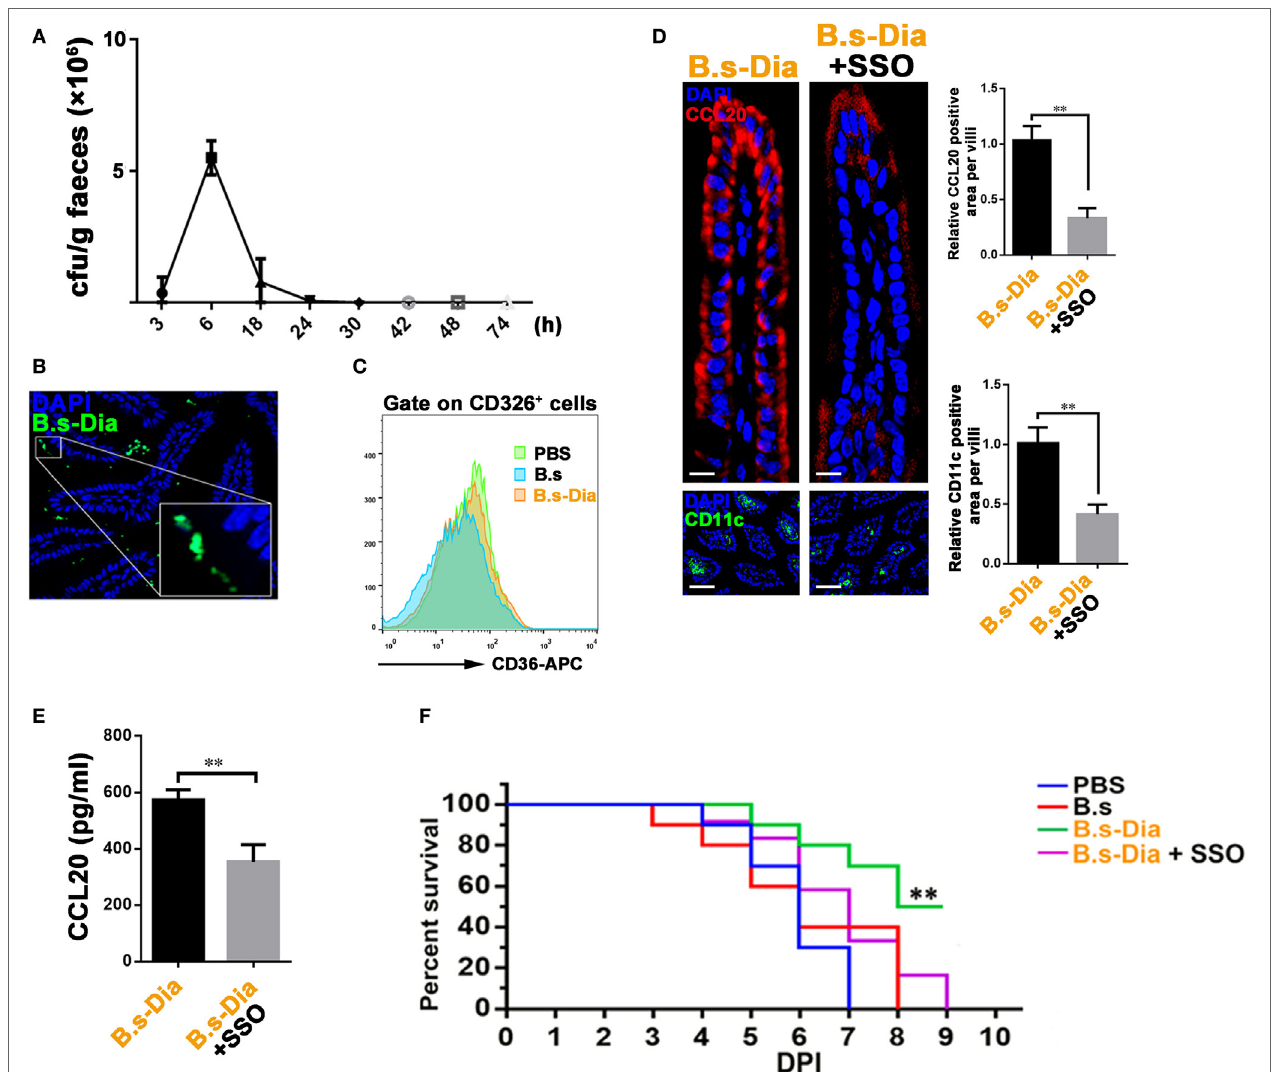
FigUre 5 | cD36 signaling was critical in 4,4 ′ -diaponeurosporene-producing Bacillus subtilis (B.s-Dia)-induced immune process . (a) Mice were intragastrically administrated with 1 × 10 9 colony forming units (cfu) B.s-Dia, and the number of B.s-Dia in mouse feces at indicated time points were detected by plate count. (B) Six hours after intragastrical administration of Dylight 488 labeled B.s-Dia, the distribution of B.s-Dia was detected by confocal microscope. B.s-Dia (green), DAPI (blue). (c) The intestinal epithelial cells (IECs) of indicated mice were digested, and the expression of CD36 on CD326 + IECs was measured by flow cytometry. (D) Mice were intragastrically administrated with 1 × 10 9 cfu B.s-Dia or equal B.s-Dia combined with 200 µg sulfo-N-succinimidyl oleate (SSO) daily for 7 days. The expression of CCL20 (red) in IECs of the indicated mice was detected by confocal microscope. The staining of CD11c + cells (green) was showed in below panels. Scale bar, 20 µm in above panel and 100 µm in the below panel. (e) Mice were treated as described in (c) . IECs were then removed by EDTA digestion and cultured at 37°C for 6 h. And, the amount of CCL20 in supernatant was detected by ELISA. (F) Mice were treated as described in (D) . On day 8, all mice were intragastrically infected with 5 × 10 8 cfu Salmonella typhimurium . Mouse survival rate was recorded daily for 9 days. Survival curves were analyzed using a Kaplan–Meier survival analysis with log-rank tests, n = 12. Other data were analyzed via one-way ANOVA test (** P < 0.01, * P < 0.05). One representative of three similar independent experiments is